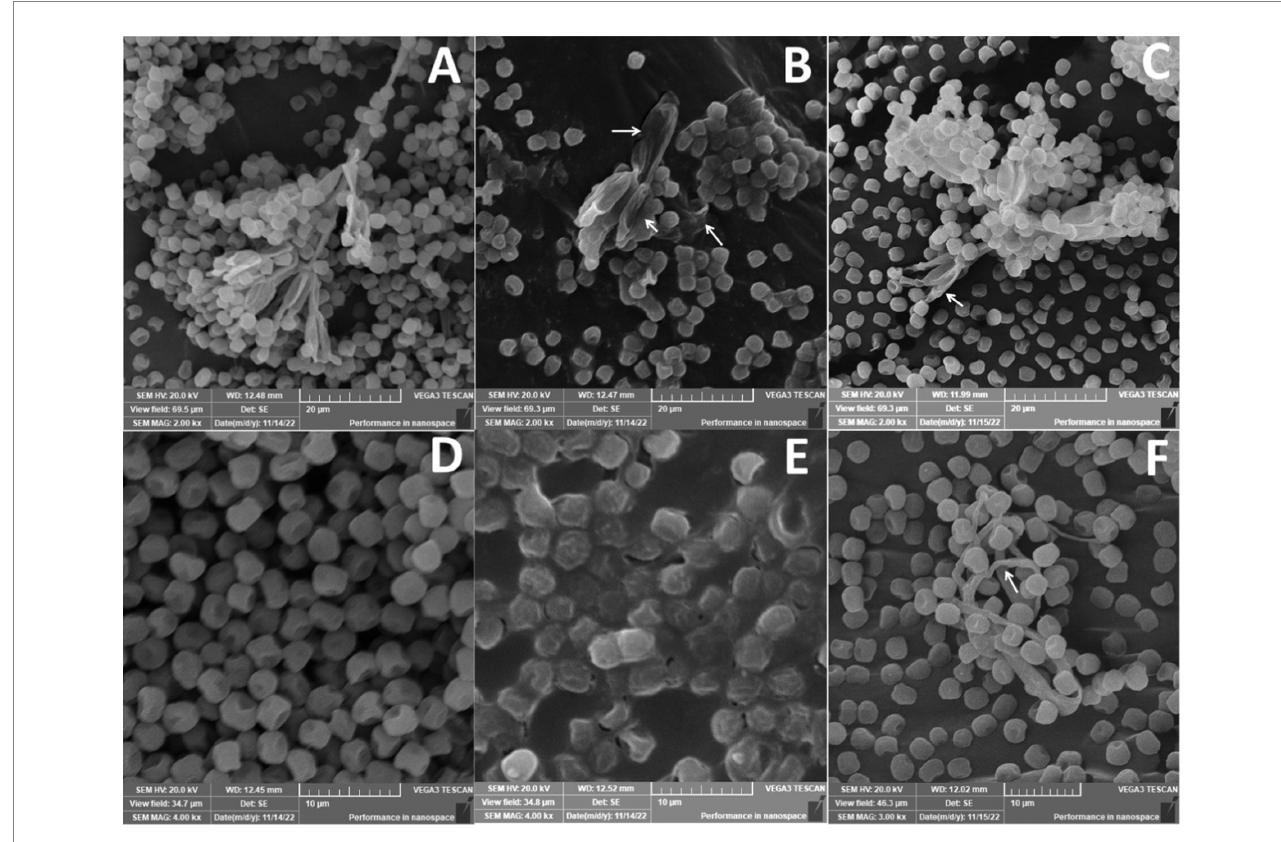
FIGURE 12 Scanning electron microscope of Penicillium verrucosum treated with different nanoemulsions: (A,D) Control, (B,E) 10_T20, and (C,F)